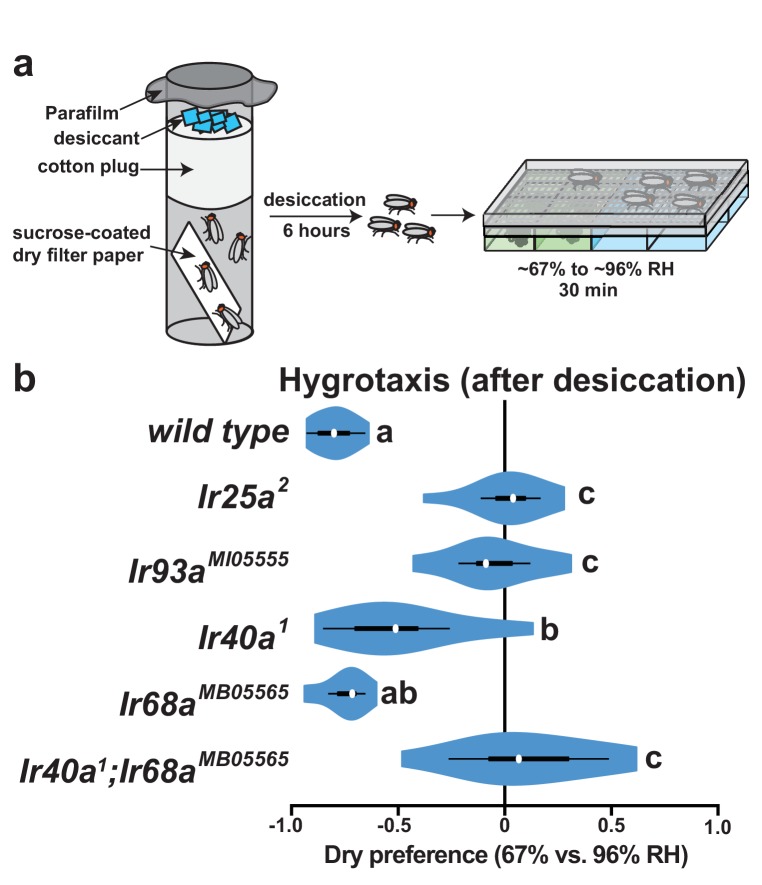
Ir40a and Ir68a each contribute to hygrotaxis in dehydrated flies.(a) Schematic of hygrotaxis assay using dehydrated flies. (b) Hygrotaxis behavior in dehydrated flies. Letters denote statistically distinct groups (p<0.01, Tukey HSD). Genotypes: wild type (n = 15 assays). Ir25a2 (n = 13). Ir93aMI05555 (n = 14). Ir40a1 (n = 12). Ir68aMB05565 (n = 11). Ir40a1;Ir68aMB05565 (n = 12). Source data for summary graph are provided in Figure 4—source data 1.DOI:
http://dx.doi.org/10.7554/eLife.26654.00810.7554/eLife.26654.009Figure 4—source data 1.Hygrotaxis behavior data.Primary hygrotaxis behavior data for Figure 4.